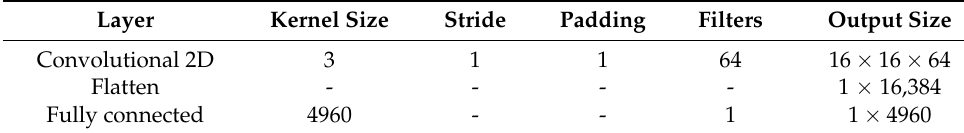
Table 7. One convolutional layer SNN (model 1).